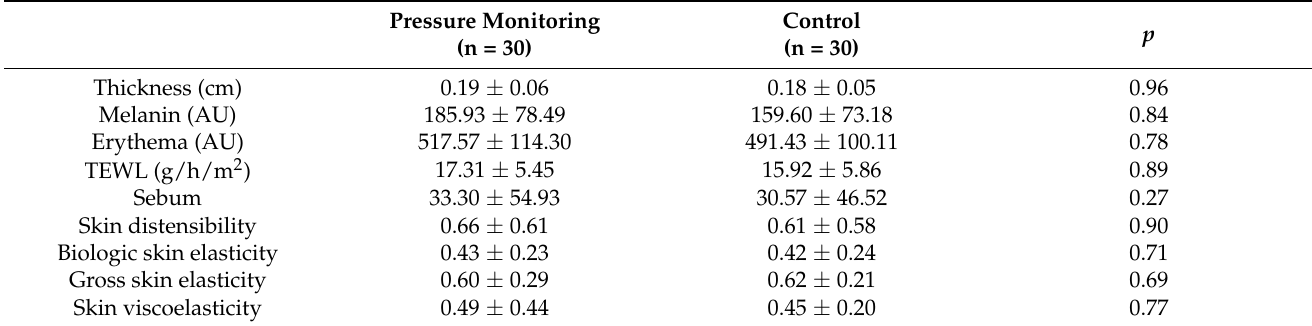
Table 2. Pre-homogeneity test of initial assessment.